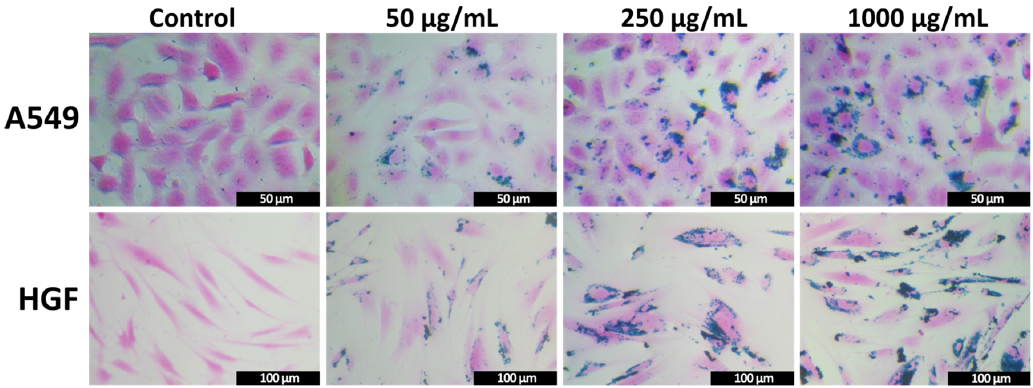
Figure 7. Microscopic images of A549 (upper panels) and HGF (lower panels) cells incubated with Prussian blue stained IOMNPs at different concentrations 0, 50, 250, and 1000 μ g IOMNPs /mL for 24 h.